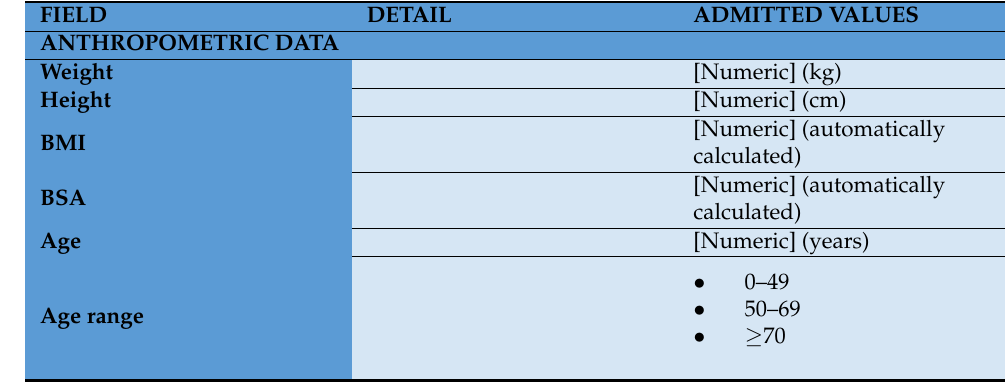
Table A1. Patient’s clinical data (imported from